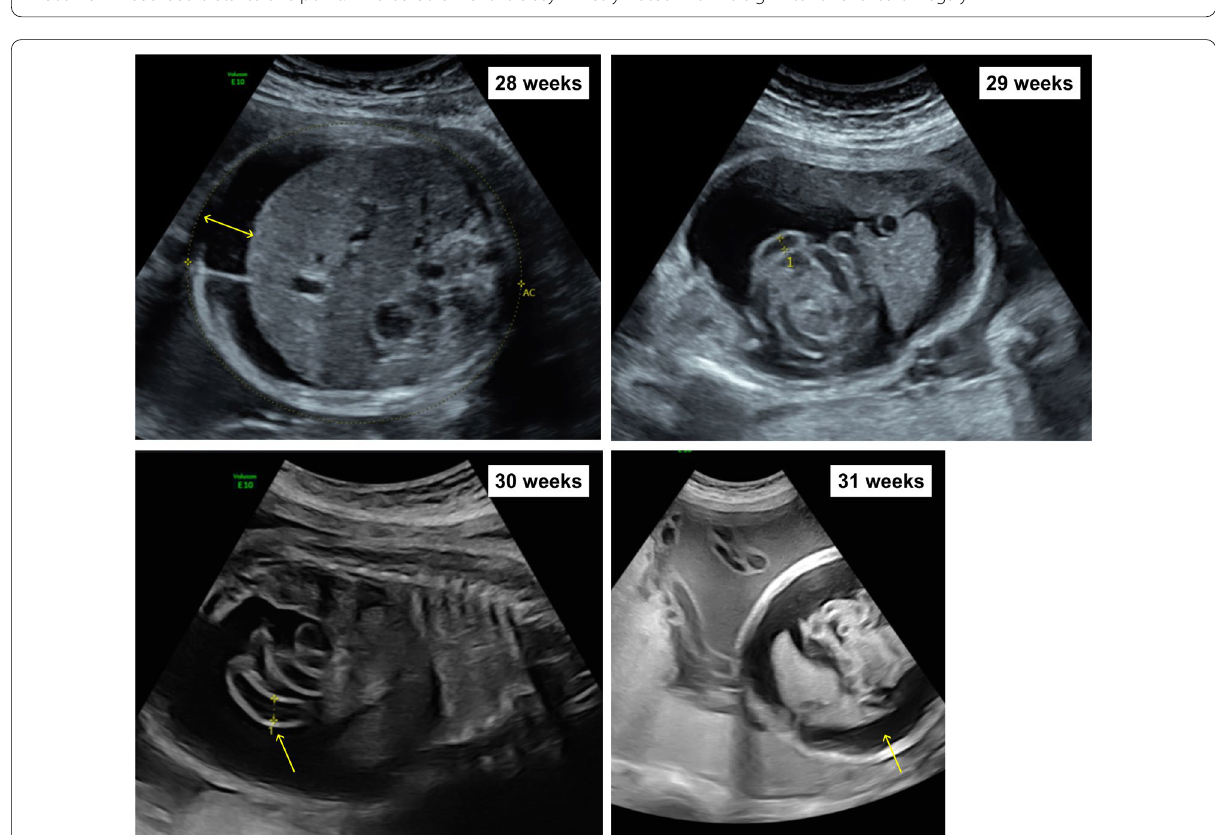
Fig. 3 Grayscale serial foetal morphology ultrasound scan images. 28 weeks of gestation: Increased ascites (16 mm, yellow resonance arrow) in the abdominal cavity coupled with decreased small bowel dimensions (2-3 mm) consistent with bowel perforation. 29 weeks of gestation: Foetal appearance is unchanged with persistent large volume of free fluid in the abdominal cavity. 30 weeks of gestation: Volume of echo-free ascites significantly increased with free loops of small bowel seen floating within it (yellow arrow). The picture is unusual for a bowel perforation and raised further suspicion for atresia secondary to an underlying metabolic or chromosomal disorder. 31 weeks of gestation: Ascites further increased with acute concurrent rise in amniotic fluid index (23 cm) and